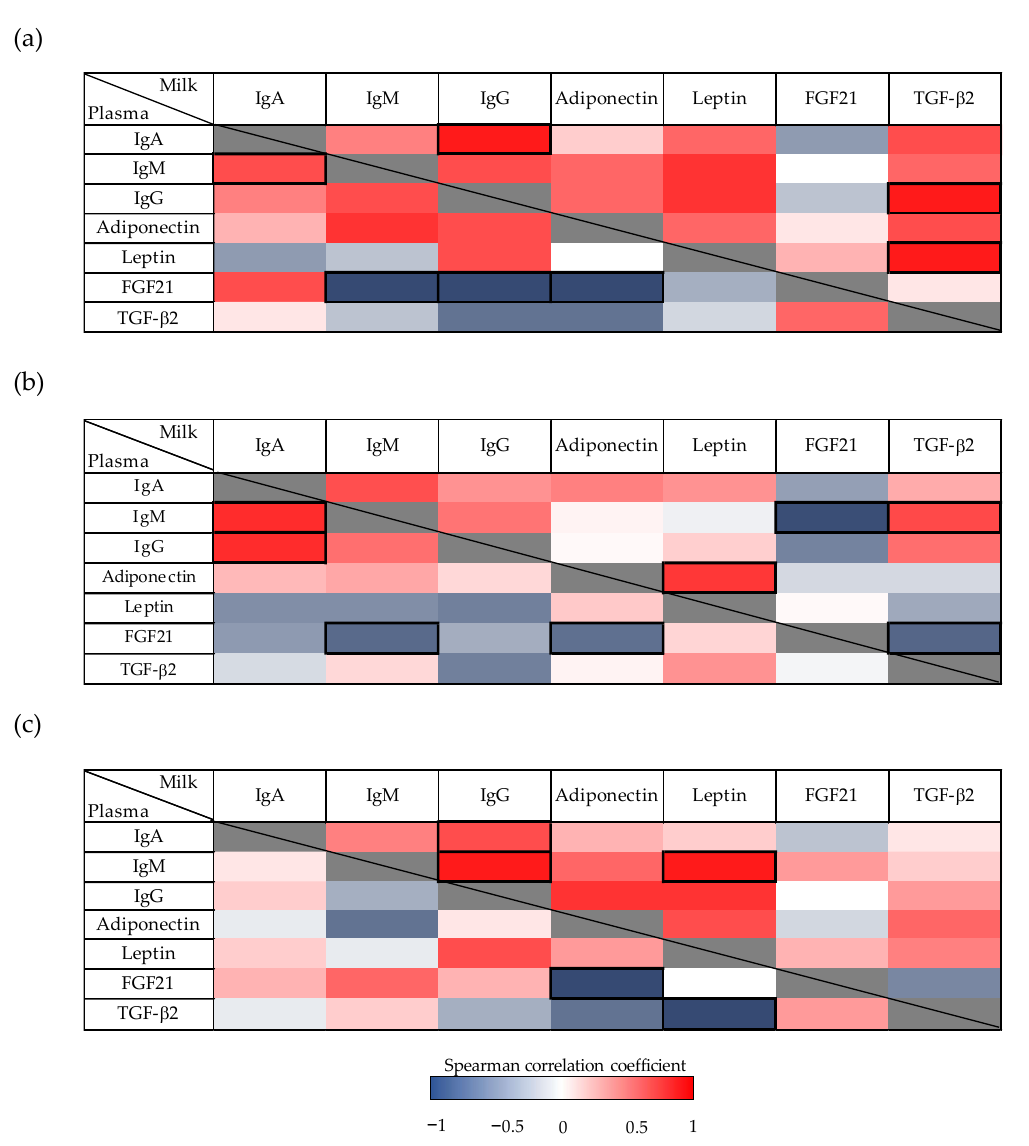
Figure 4. ( a ) Correlations between immunoglobulins (Ig), adipokines, and growth factor concentrations in milk and plasma from dams throughout the lactation period. Analyses were performed, considering values as their area under the curve during the whole suckling period (AUC total ), and ( b ) AUC on the first (AUC d3–10 ) and ( c ) the second period (AUC d14–21 ) of the study. The Spearman correlation coefficient is represented in the heat map following the color in the legend. Correlations with statistical significance ( p < 0.05) are shown in a bold frame ( N = 6–8). TGF- β 2, Transforming growth factor- β 2; FGF21, fibroblast growth factor 21.